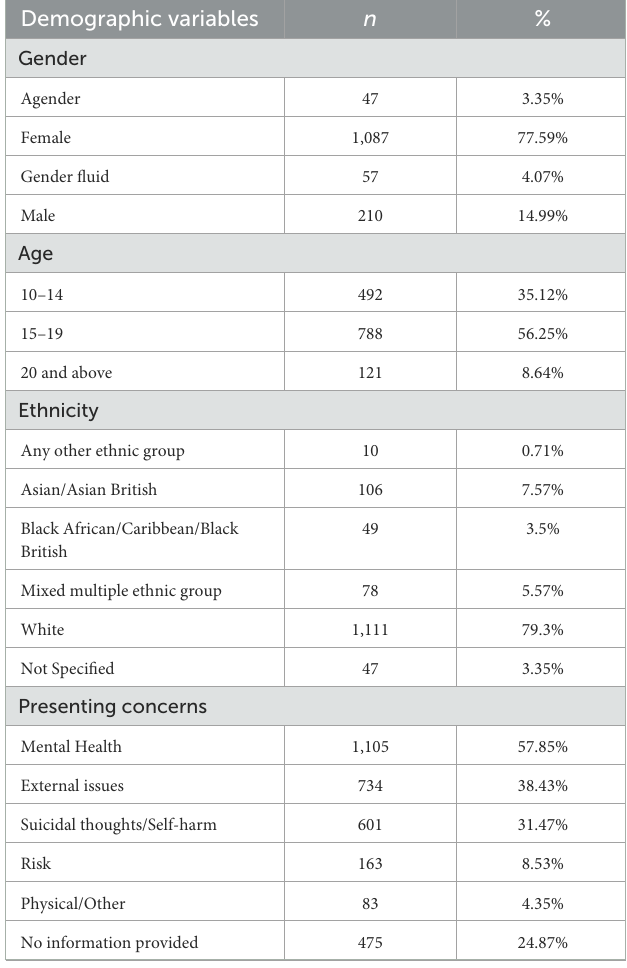
TABLE 1 Demographic characteristics a